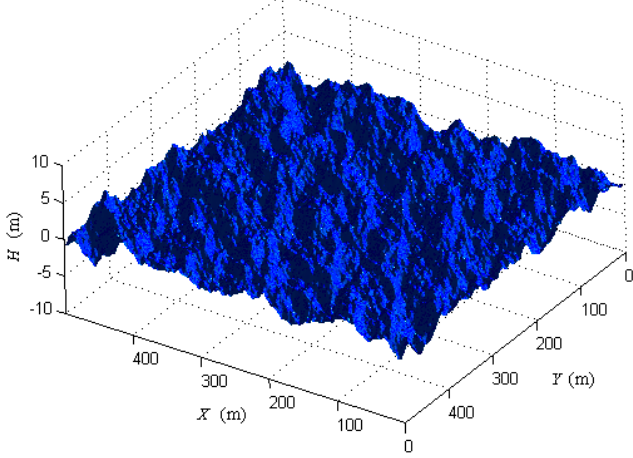
Figure 7. The wave graphs of sea state 5.